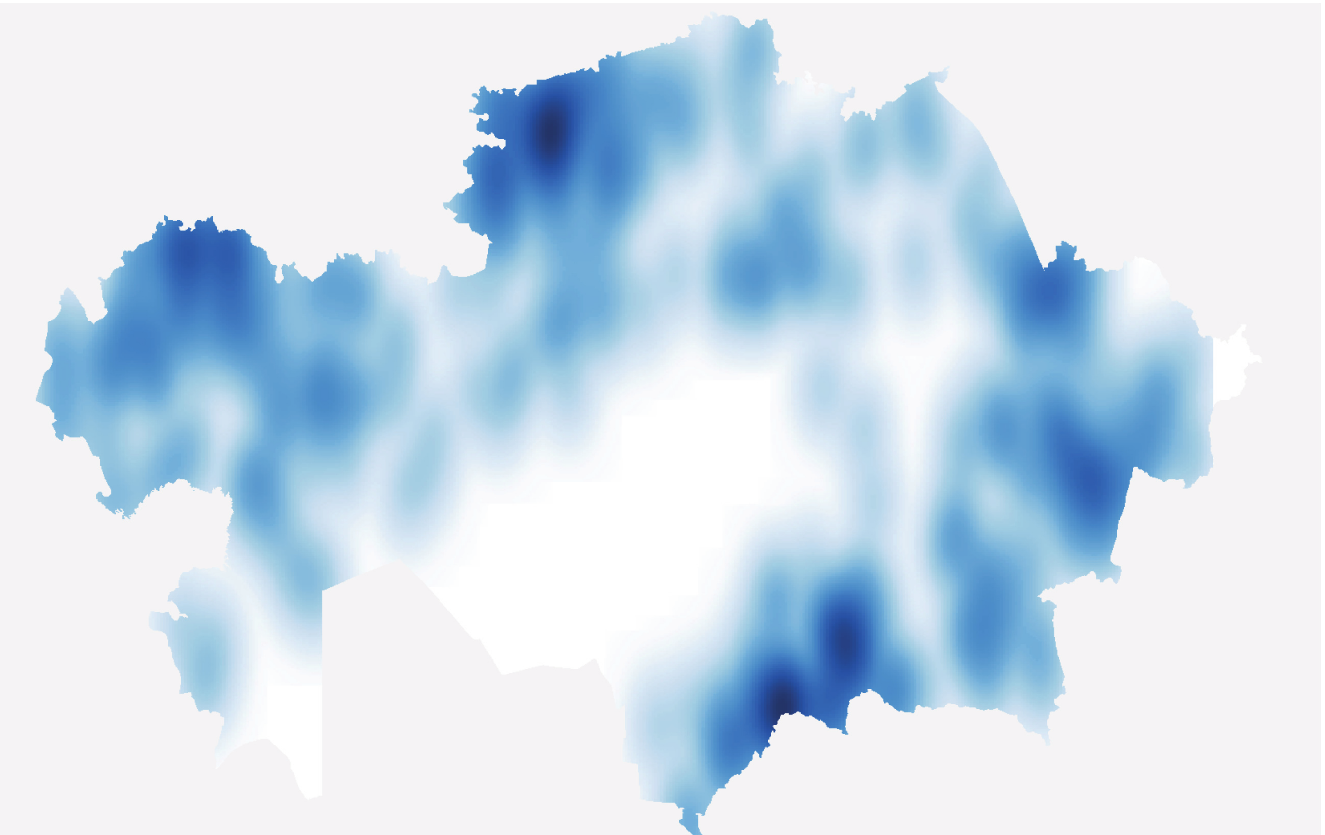
Fig 2. Kernel density estimation for outbreaks of animal rabies in Kazakhstan between 2003 and 2013. The darker the shading indicates a higher density of outbreaks. White is where there are no outbreaks.